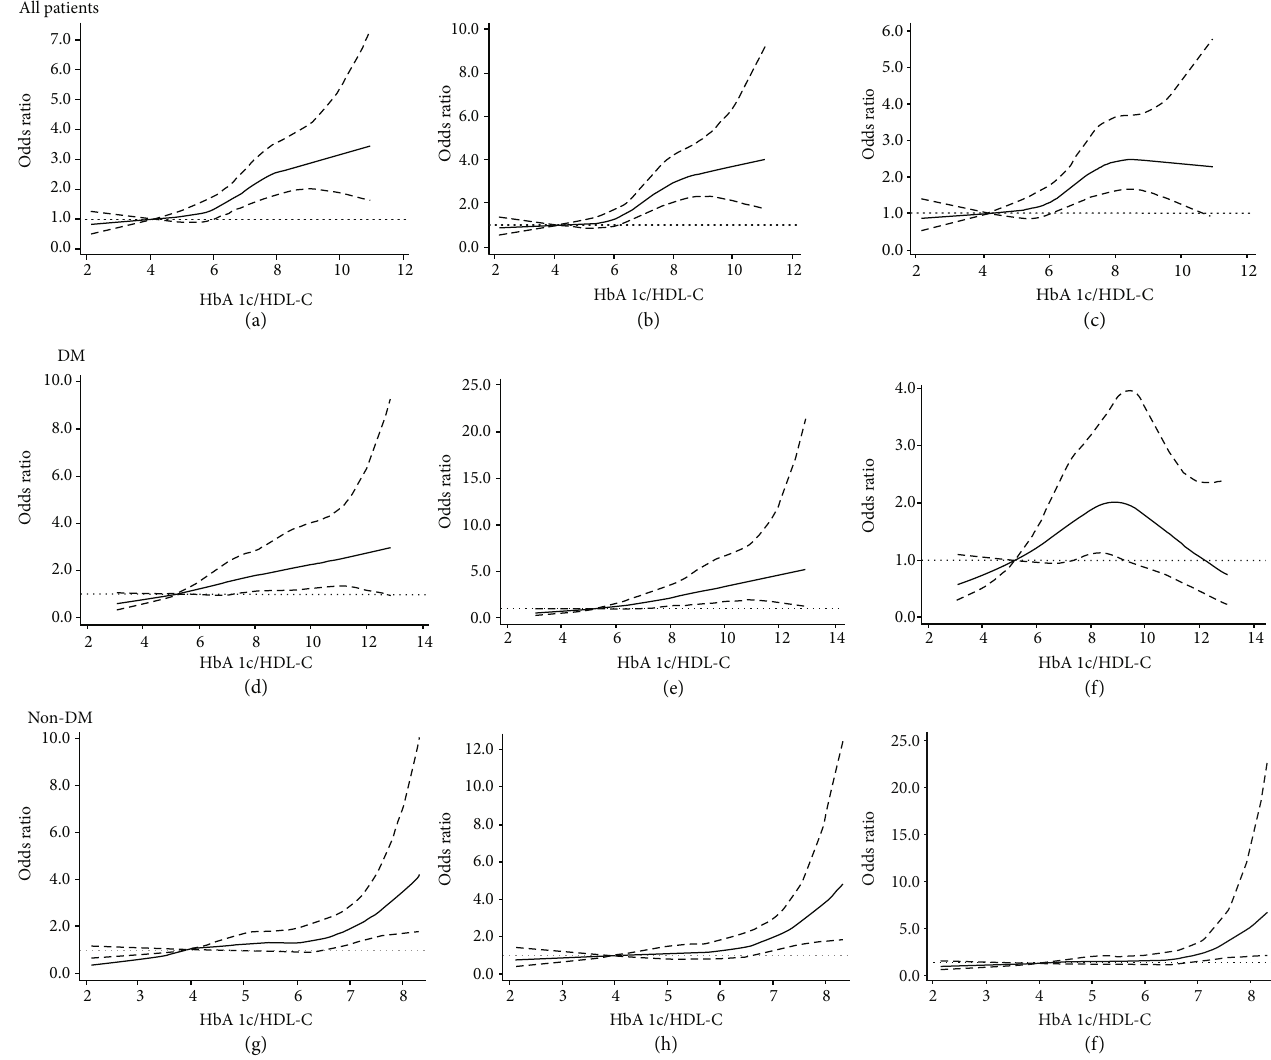
Figure 3: Association of the HbA1c/HDL-C ratio with carotid atherosclerosis. (a) Abnormal mean cIMT in all patients; (b) abnormal maximum cIMT in all patients; (c) carotid artery plaque in all patients; (d) abnormal mean cIMT in patients with DM; (e) abnormal maximum cIMT in patients with DM; (f) carotid artery plaque in patients with DM; (g) abnormal mean cIMT in patients without DM; (h) abnormal maximum cIMT in patients without DM; (i) carotid artery plaque in patients without DM. Odds ratios and 95% con fi dence intervals (CIs) were adjusted for the same variables as in model 4 (Table 2). The reference value of the HbA1c/HDL-C ratio is the median of the reference group. The area between the two dotted lines represents the 95% CI. Owing to the small sample and large 95% CI, the highest 4% of patients are not shown in the fi gure. HbA1c: hemoglobin Alc; HDL-C: high-density lipoprotein cholesterol; cIMT: carotid intima-media thickness; DM: diabetes